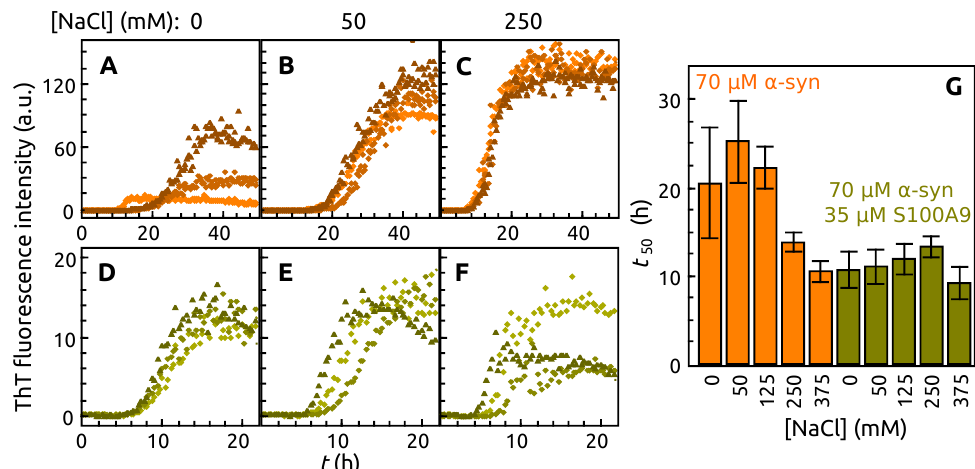
Figure 4. Aggregation kinetics of α -syn without ( A – C ) and with S100A9 ( D – F ) in a presence of different NaCl concentrations: 0mM ( A , D ), 50mM ( B , E ), 250mM ( C , F ). Each sample represented by 3 mostly recurring curves. The t 50 value (determined from 12 repeats) of α -syn (orange) and α -syn aggregated with S100A9 (olive) at different concentrations of NaCl ( G ). Protein solution: 70µM α -syn, 0µM or 35µM S100A9, 50µM ThT, 0.02% NaN 3 , PBS buffer, pH7.40. When additional 50 mM NaCl is present in the aggregation reaction mixture, the profile of FTIR spectrum and the second derivative are very similar to the one of A3 population (Figure 5A,B). A further increase in NaCl concentration has minimal effect on the FTIR spectra, apart the minima at 1640 cm − 1 and the more expressed shoulder at 1614 cm − 1 , indicating a minor change of hydrogen bond strength.